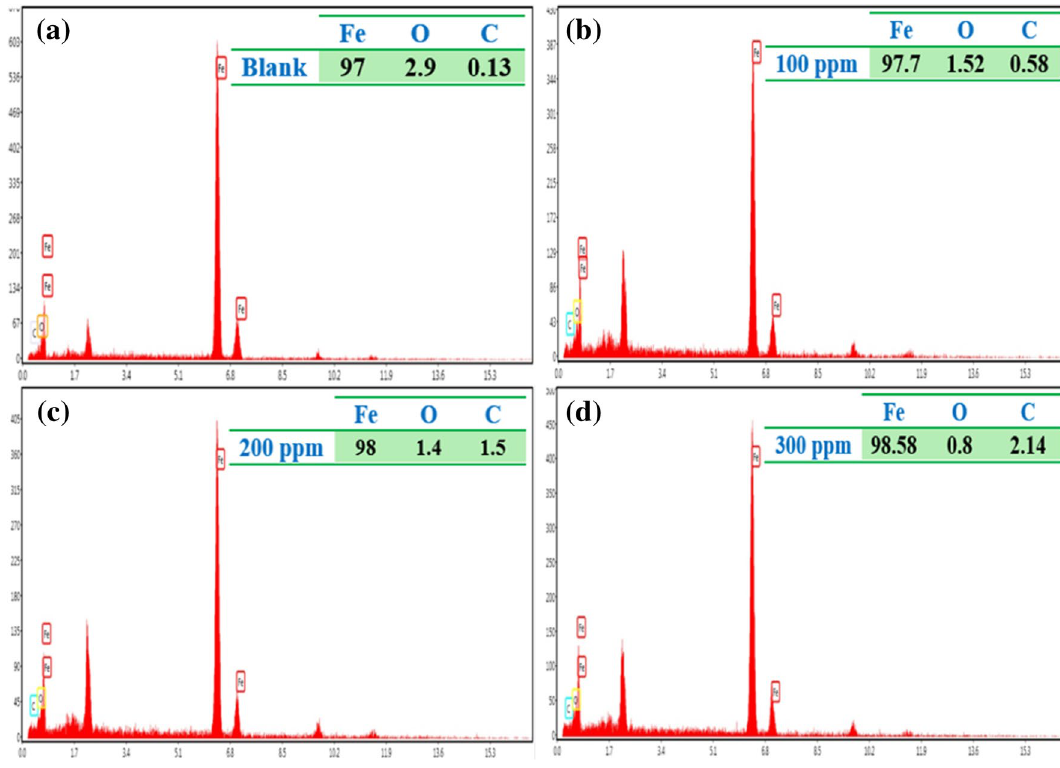
Figure 8. Energy dispersive X-ray (EDX) after exposure to ( a ) 0; ( b ) 100, ( c ) 200, and 300 ( d ) ppm